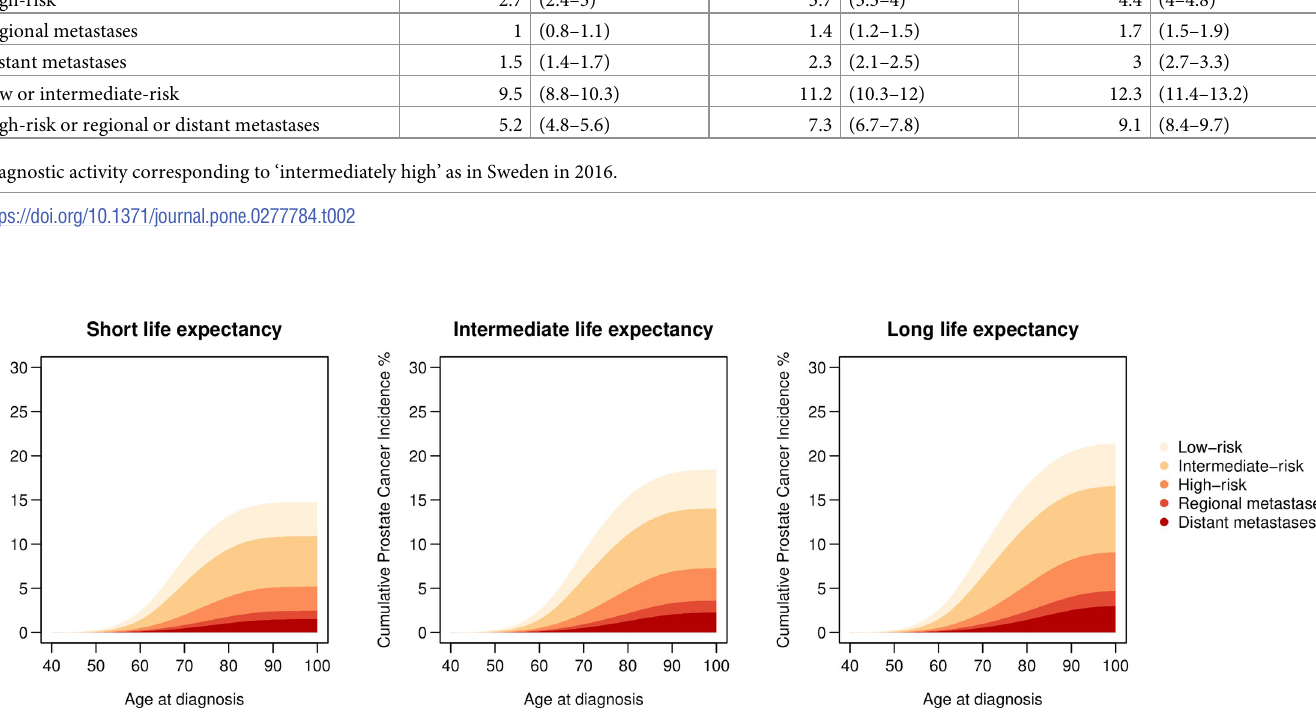
Fig 2. Cumulative incidence of prostate cancer diagnosis by risk category for a simulated follow-up of 2,000,000 men from age 40 to age 100 under three different levels of life expectancy: Short as for birth cohort 1912; Intermediate as for birth cohort 1952; Long as for birth cohort 1992.